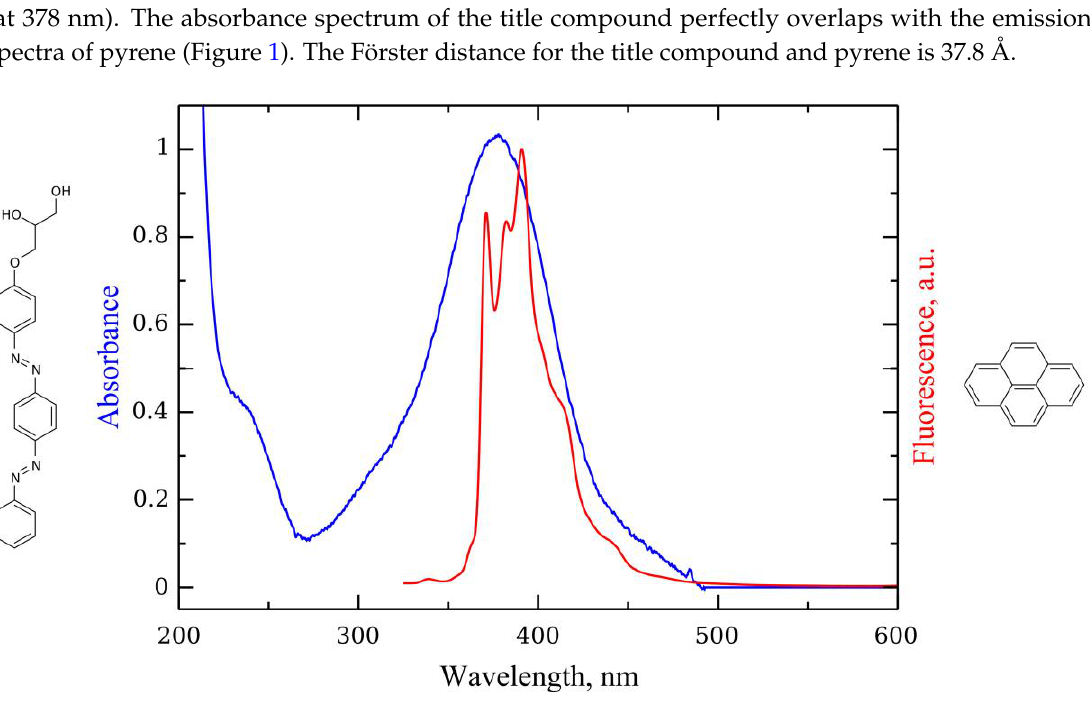
Figure 1. Spectral overlap. Blue: absorbance spectra of the title compound in ethanol. Red: emission spectra of the pyrene fluorophore in ethanol.